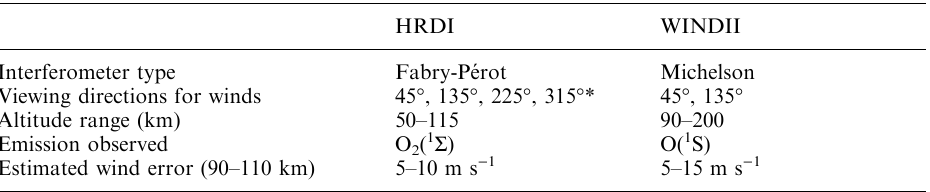
Table 1. Summary of HRDI and WINDII instruments and data sets employed in present study (* Only 45 (cid:176) and 135 (cid:176) azimuth data are used in com- parisons with WINDII.)